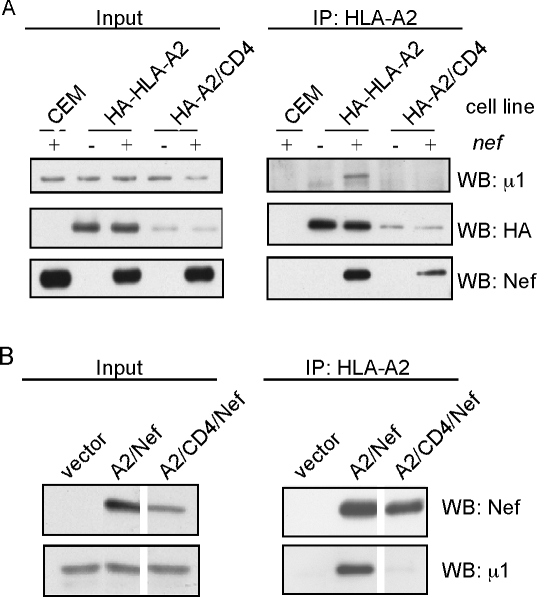
Selective binding of AP-1 is dependent on the cytoplasmic tail.(A) The HLA-A2 cytoplasmic tail is necessary for co-precipitation of
AP-1. Parental HLA-A2-negative CEM T cells (CEM) or CEM T cell lines
expressing HA-HLA-A2 or HA-A2/CD4 were transduced with adeno-Nef or a
control adenovirus. Lysates were immunoprecipitated with an antibody
directed against HLA-A2 (BB7.2) and the presence of Nef or AP-1 was
detected by western blot analysis. Results are representative of three
independent experiments. (B) The cytoplasmic tail is necessary for the
HLA-A2/Nef fusion protein to co-precipitate AP-1 in Nef expressing T
cells. CEM T cells were transduced with a murine retroviral vector
expressing no protein (vector), A2/Nef or A2/CD4/Nef fusion proteins.
These cells were immunoprecipitated with an anti-HLA-A2 antibody (BB7.2)
and western blot analysis was performed to detect co-precipitation of
AP-1. Spaces between lanes indicate where intervening lanes were cropped
out to remove irrelevant data. Results are representative of two
independent experiments.